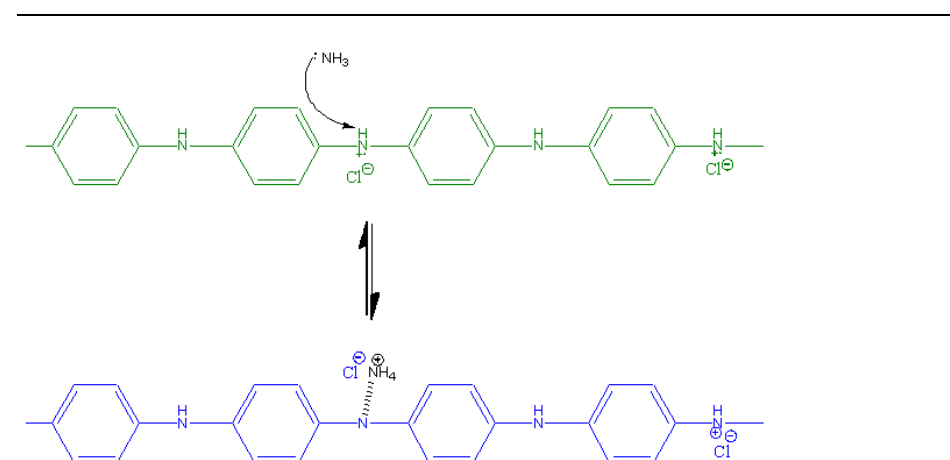
Figure 9. The interaction mechanism between PANI and ammonia.